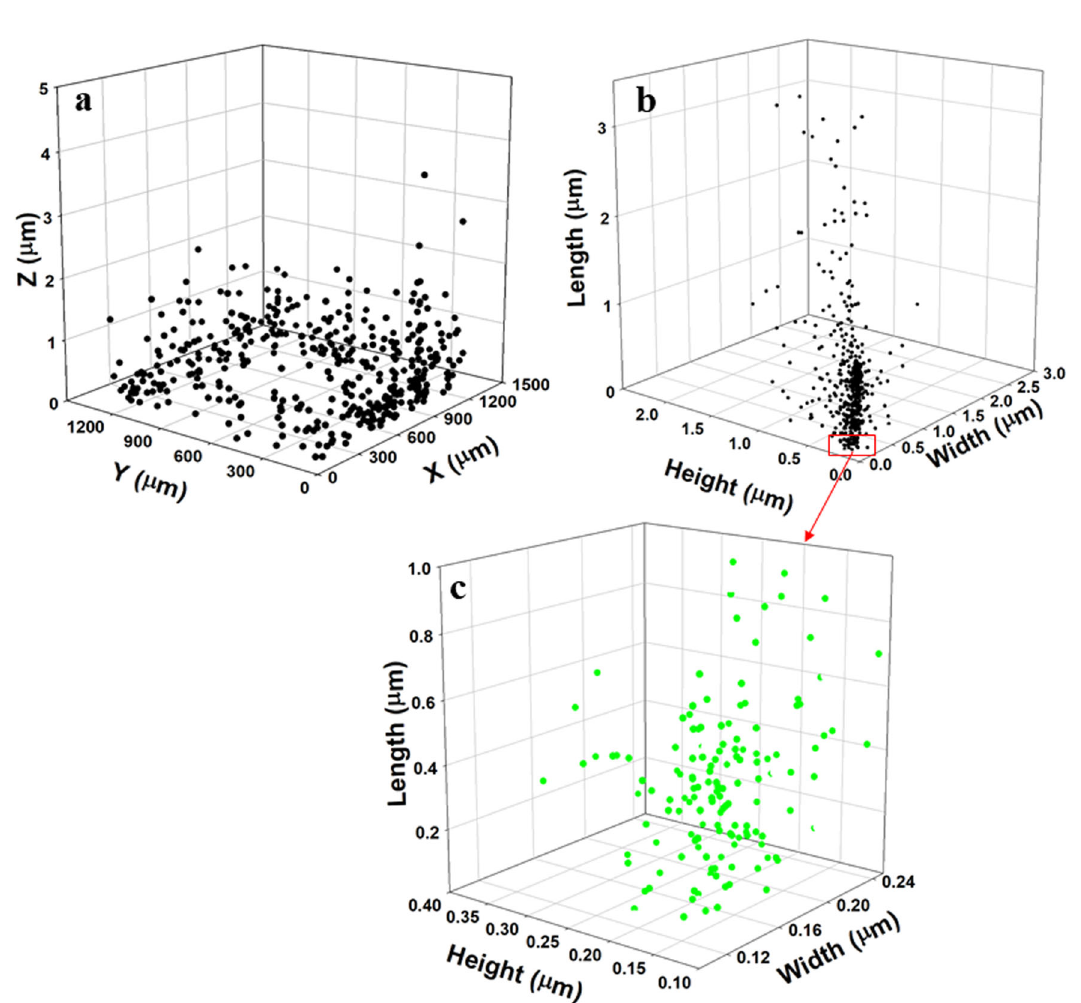
Fig. 2 3D size distribution of 100 nm PSL spheres in the aerosol phase. a The orientation of PSL particles. b Width, height, and length distribution of PSL particles in a single hologram over 62.5 ms. c Highlighted PSL particle size distribution from b within the nanosized width of particles. Another 3D reconstruction of different holograms is shown in Supplementary Fig.